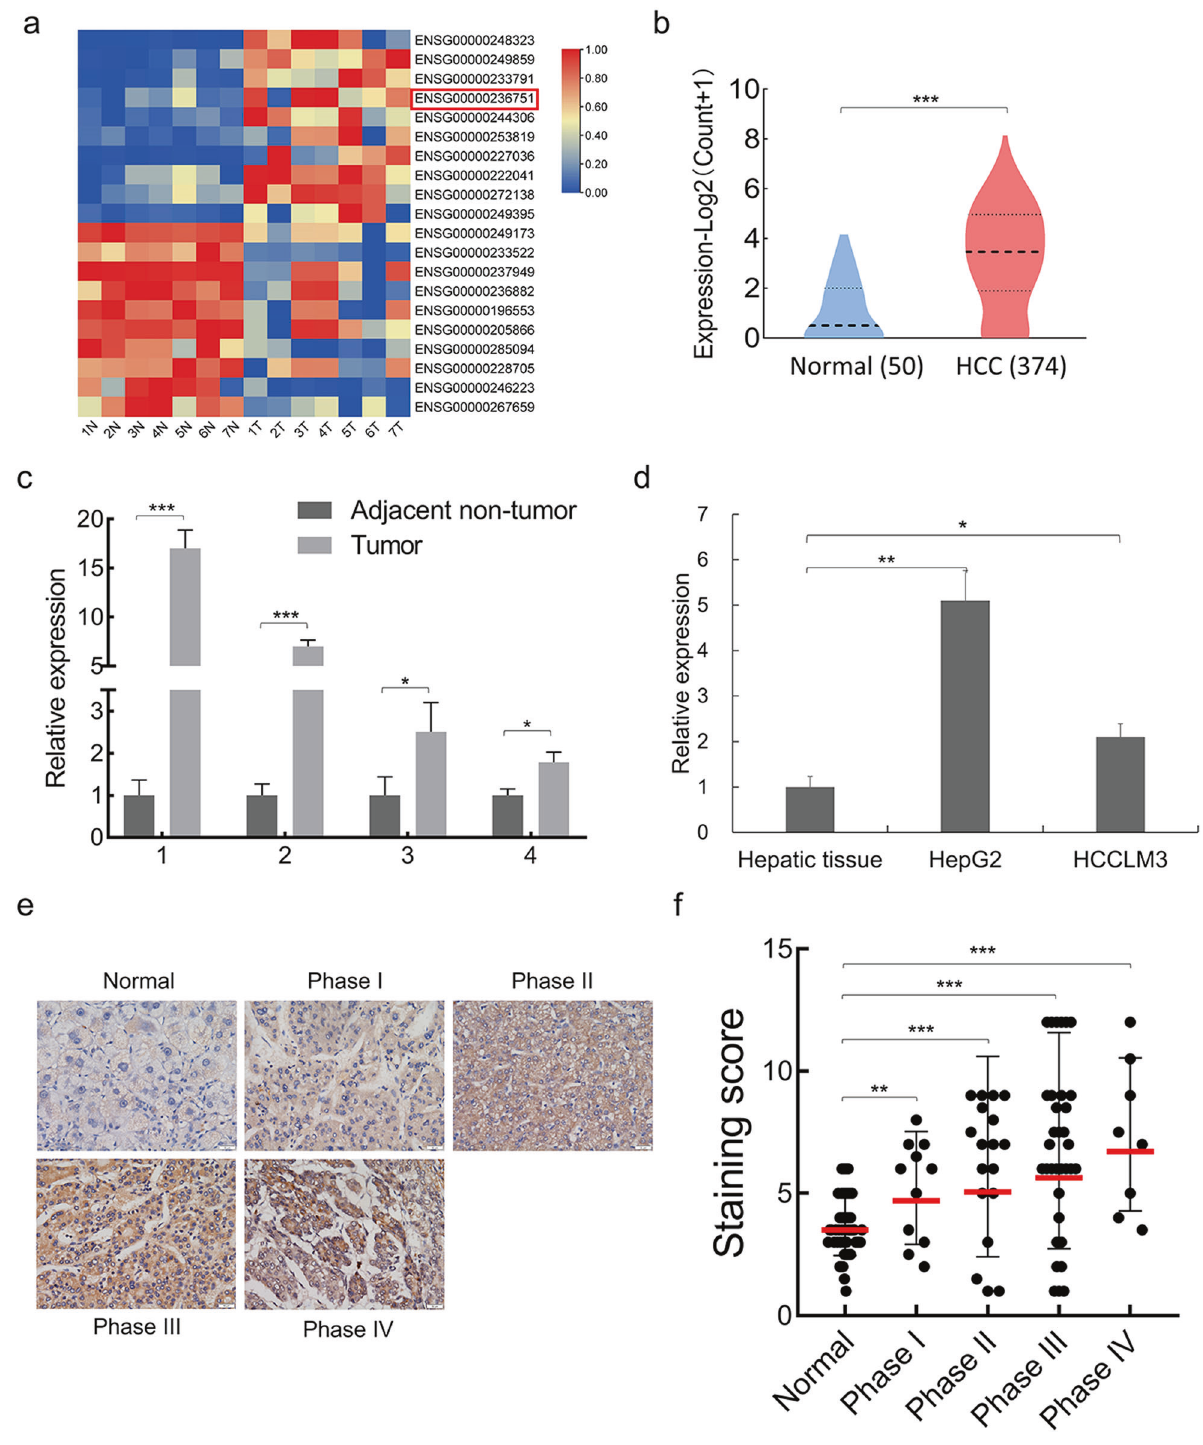
Fig. 1 SALIS is higher-expressed in HCC tumors and cells. a The top 10 upregulated and downregulated LncRNAs from GSE101728 were clustered and shown in heat map. SALIS was highlighted using a red box. b The expression of SALIS in HCC (374 cases) compared with normal tissues (50 cases). The original expression data is from The Cancer Genome Atlas Program (TCGA) database. c Detection of the expression levels of SALIS in 4 paired clinicl samples of HCC and adjacent non-tumor tissues by qPCR. d Comparison of SALIS expression between normal hepatic tissue and HCC cell lines (HepG2 and HCCLM3) by qPCR. The qPCR data represent the average of three independent experiments ±s.d. e in situ hybridization (ISH) detection of SALIS in HCC tissue array and adjacent normal specimens. Representative images with various levels of staining (negative or weak from normal tissues, strong from tumor tissues) are shown. Scale bar: 50 μ M. f Association of SALIS expression scores with AJCC tumor stages (Phase I, II, III, and IV). Data are plotted as the means of 95% con fi dence interval ± s.d. * P < 0.05, ** P < 0.01, *** P < 0.001.